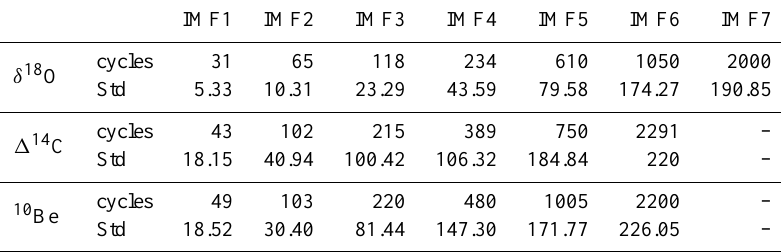
Table 1. Cycles of δ 18 O, 1 14 C and 10 Be with the EMD method.